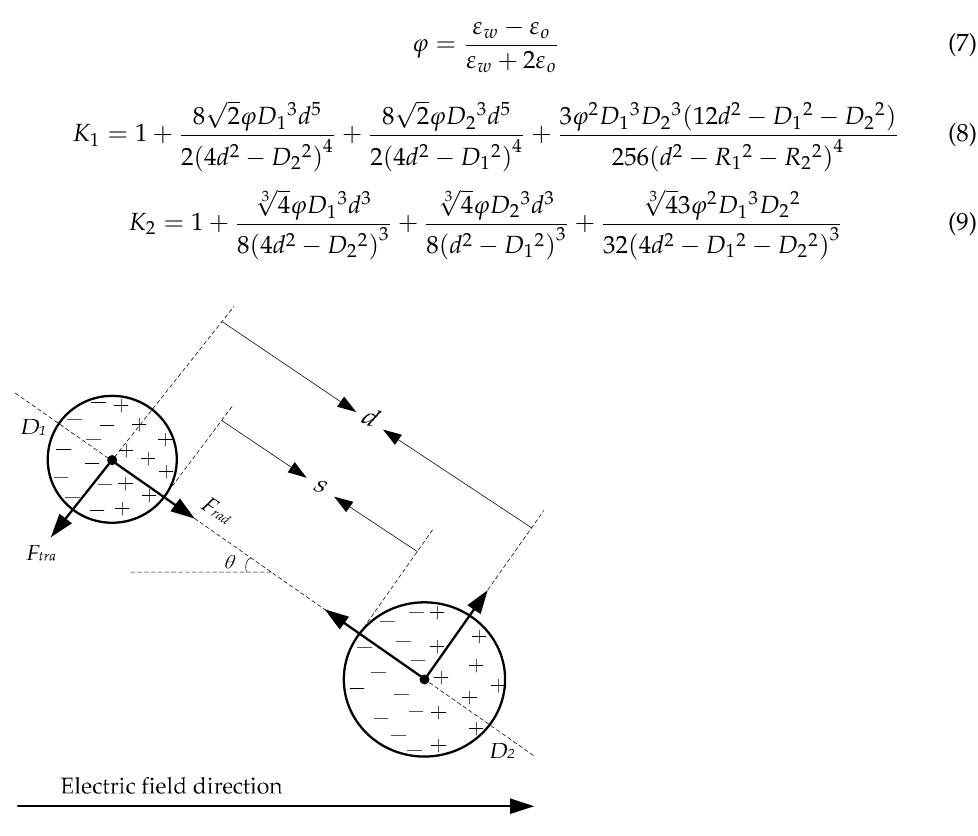
Figure 2. Dipole force model for conductive droplets. It may be noticed that the dipole force is inversely proportional to the fourth power of the distance between the droplets, which means that the dipole force decreases rapidly as the distance between the droplets increases. However, when the water cut of the oil is high, the droplet density is sufficiently large, and there will be many of these close contacts, which are good ways of increasing droplet size. The internal overall layout of the electric-field-enhanced oil–water separation device is shown in Figure 3. The produced liquid from the wells is fed into hydrocyclones for preliminary separation of the gas and liquid. The gas released is discharged through the gas outlet and collected for use. The liquid enters the horizontal separator after passing through the bottom devortexer. The oil in the liquid floats up through the coalescing packing assembly to form an oil phase, and after dehydration in the rectangular channel of the VIEC, it overflows the weir plate and flows out of the oil outlet at the bottom of the tank. The basic parameters of the internal components of the oil–water separation device were designed on the basis of the process data of the pilot test platform shown in Table 1, including the size and installation parameters of the coalescing packing assembly and the electrostatic coalescence module. It should be noted that only a reference value